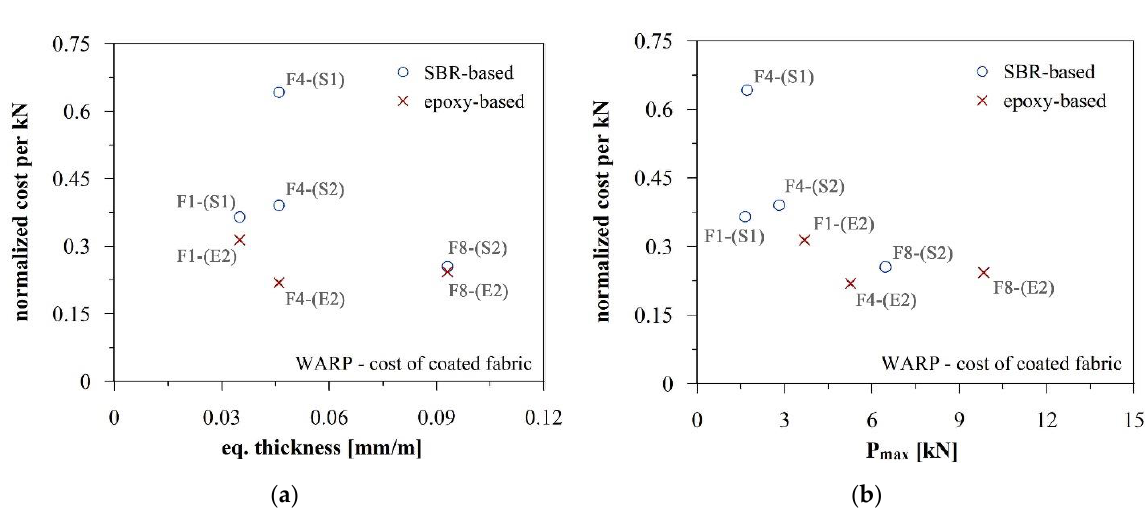
Figure 14. Normalized cost per kN vs. equivalent thickness ( a ) and maximum tensile capacity ( b ) for the TRC composites reinforced in the warp direction.